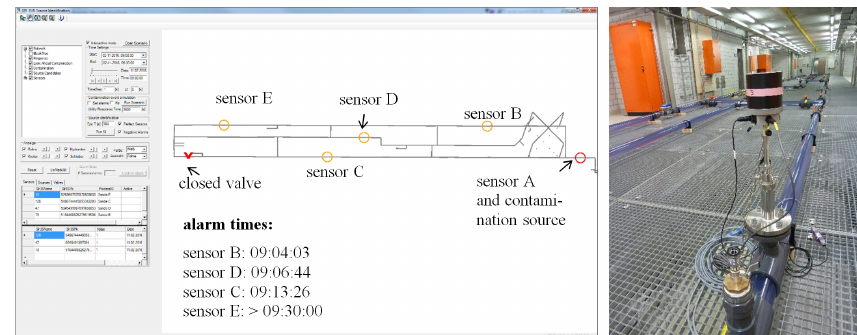
Figure 2. Test network with four sensors (orange circles) and contamination source (red